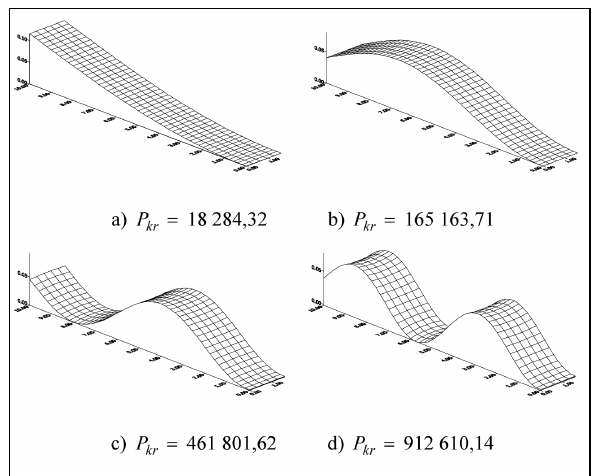
Fig 4. The first four eigenshapes